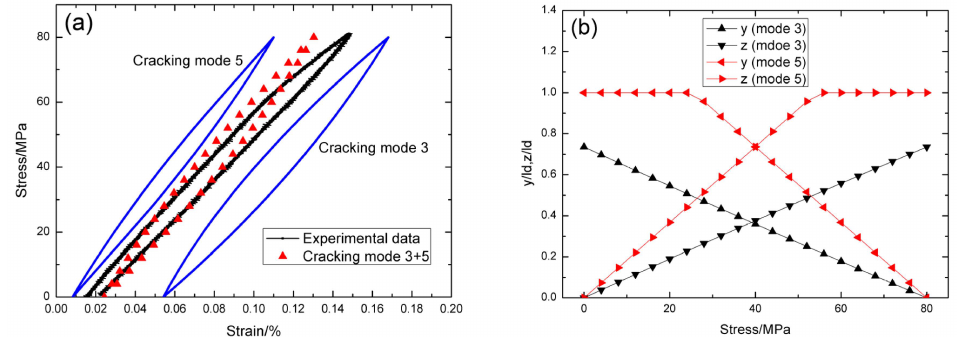
Figure 4. ( a ) The theoretical and experimental hysteresis loops; and ( b ) the interface slip lengths, i.e. , y / l d and z / l d , of matrix cracking mode 3 and mode 5 of cross-ply C/SiC composite when σ max = 80